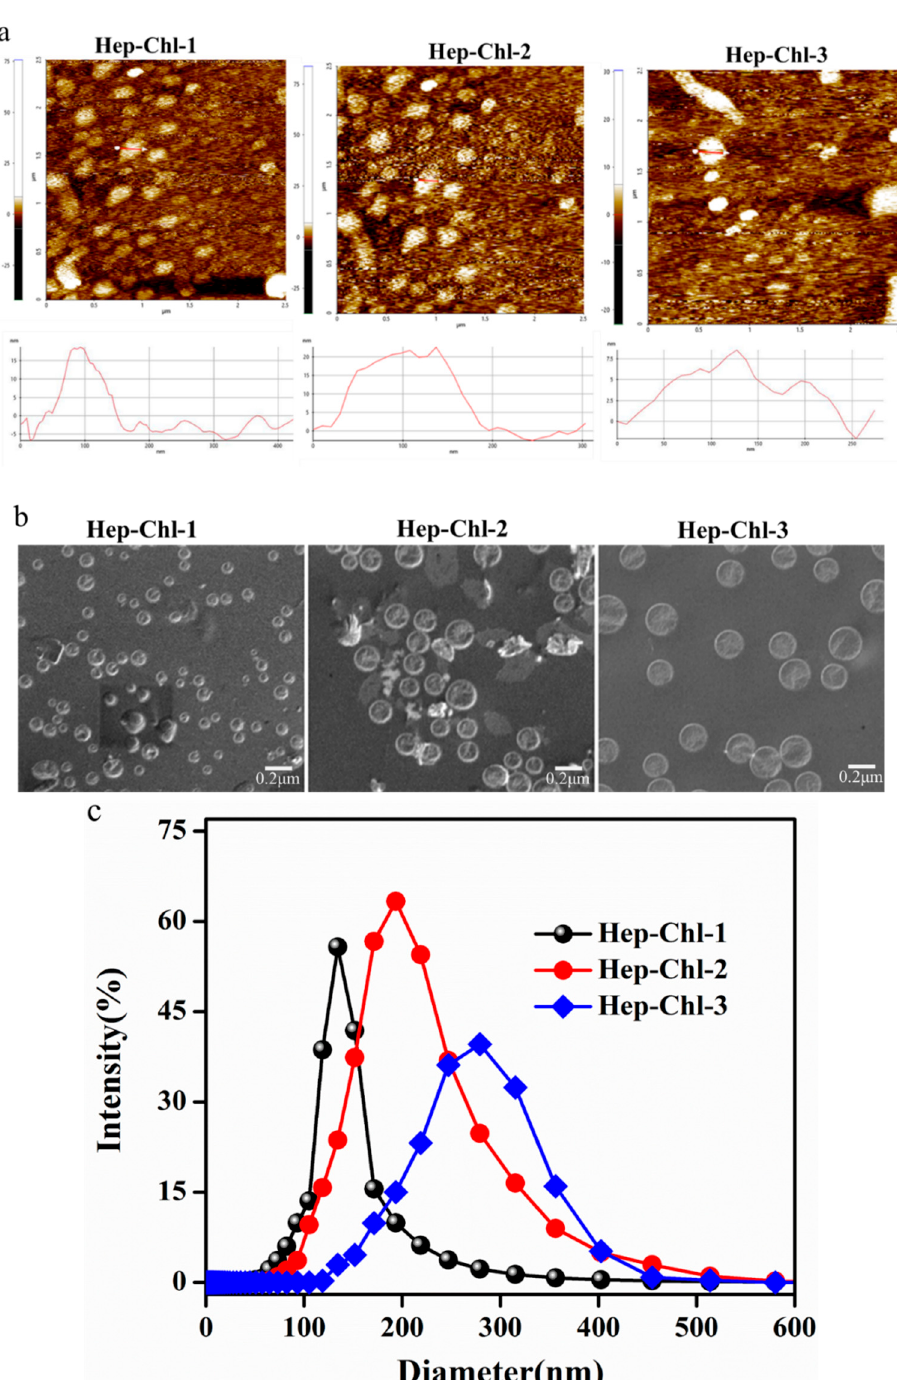
Figure 4. Particle morphology and size: ( a ) AFM images, ( b ) SEM images, and ( c ) particle size distribution Hep–Chl-1, Hep–Chl-2, and Hep–Chl-3 self-assembled prodrugs.